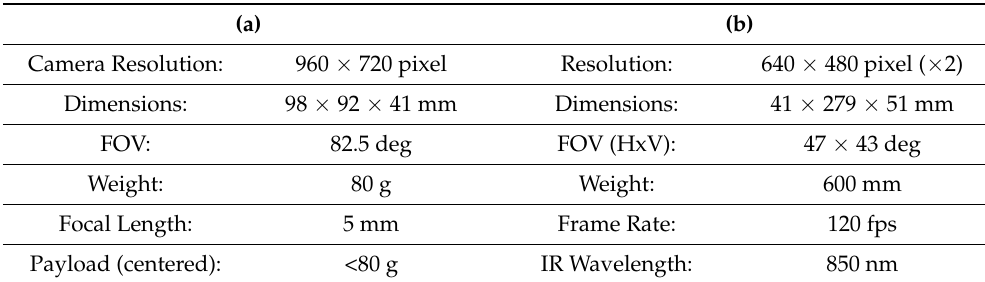
Figure 4. ( a ) DJI Tello micro UAVs with motion capture markers attached. ( b ) Portable dual-lenses motion capture device Optitrack V120 Duo. Table 1. (a) General characteristic of DJI Tello. (b) Characteristic of Optitrack V120 Duo motion capture device.